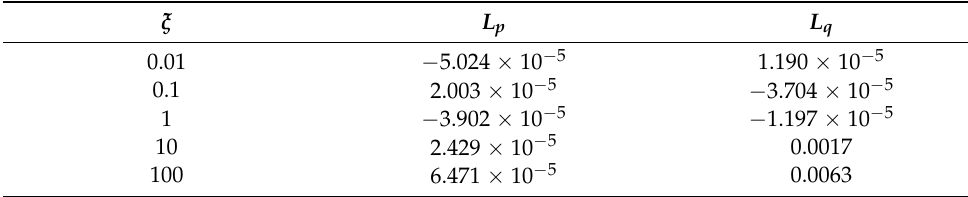
Table 3. Factors of the localization of vibration. Ω = 4750 r/min.